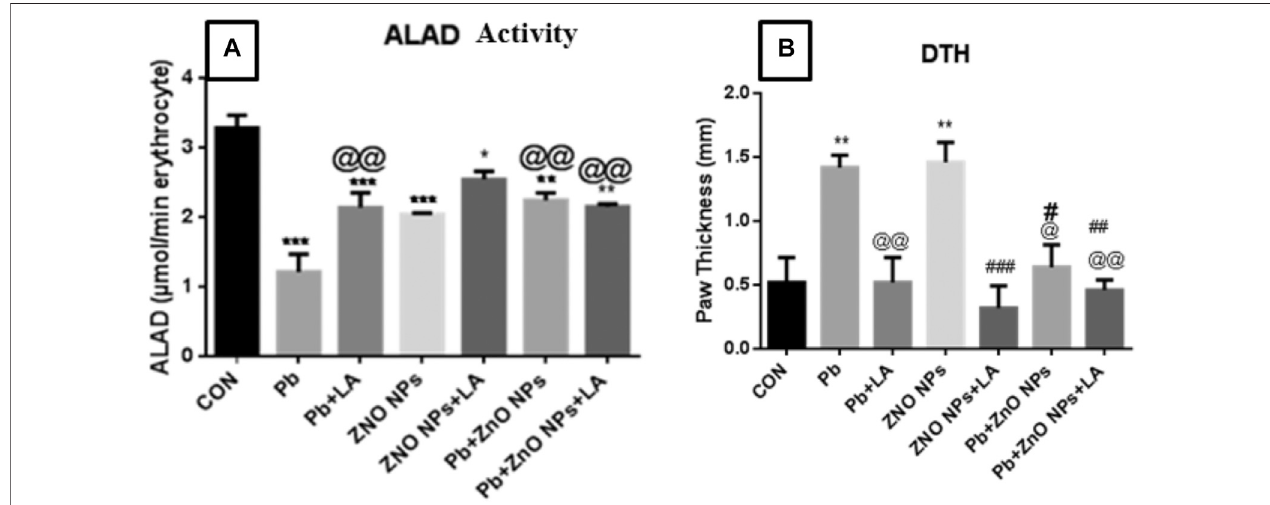
FIGURE 9 | (A) Blood delta-aminolevulinic acid dehydratase activity. (B) Rat paw thickness (in mm). All the values are expressed as mean ± SEM (n (cid:2) 5). The statistical signi fi cance was considered at p < 0.05, and statistical analysis was performed using one-way ANOVA, followed by Tukey ’ s test. * p < 0.05, ** p < 0.01, *** p